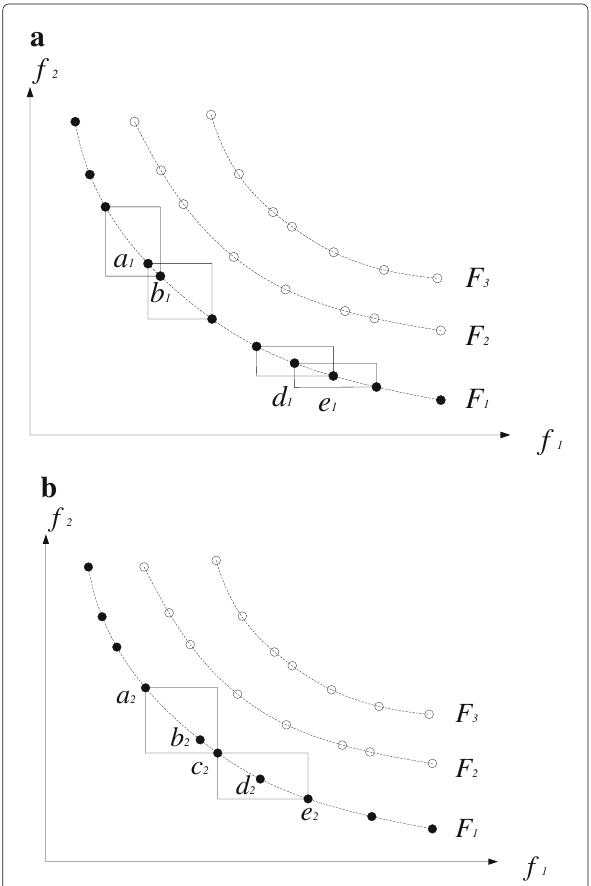
Fig. 5 Limitations of crowding distance calculation in NSGA-II. a the crowding distances of I ( a 1 ) and I ( b 1 ) are greater than I ( d 1 ) and I ( e 1 ). b I ( b 2 ) and I ( d 2 ) have the same crowding